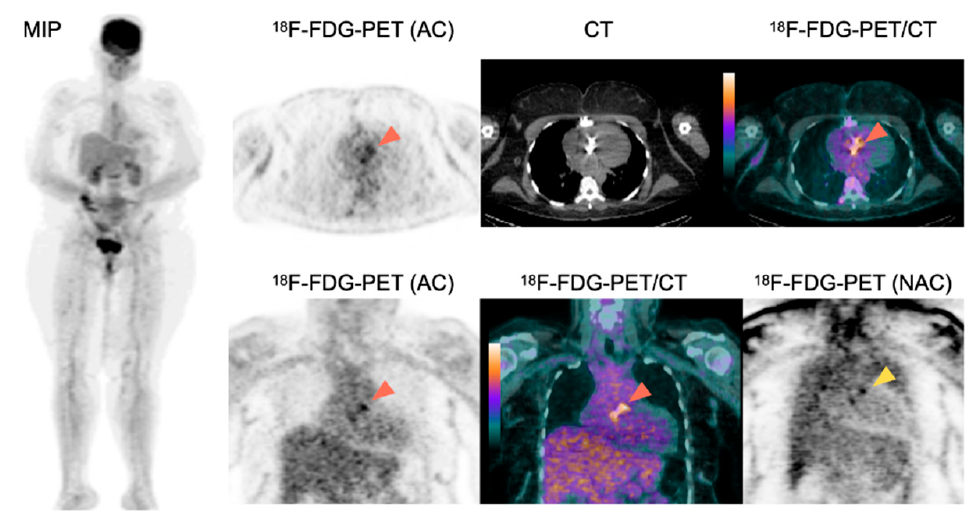
Figure 1. Role of 18 F-FDG-PET/CT for the diagnosis of PVE. A 63-year-old female patient with history of aortic valve replacement presented with a fever of unknown origin. Two blood cultures taken 12 h apart were positive for Staphy- lococcus aureus . 18 F-FDG-PET/CT showed an intense 18 F-FDG uptake around the aortic prosthetic valve on AC images (orange arrowheads), persisting on NAC images (yellow arrowhead) suggestive of PVE. The presence of two major criteria for IE classified the pa- tient as having definite IE based on the modified Duke-Li criteria. 18 F-FDG-PET showed no sign of septic emboli. Consequently, the patient underwent a prosthetic valve replacement surgery and a prolonged antibiotherapy. Conversely, the homogeneous perivalvular 18 F-FDG signal, which is only present on AC images but not on NAC images, is less suggestive of PVE [24]. In case of a suspicion of CIED or LVAD infection, focal/linear 18 F-FDG uptake around the material on AC acquisitions, particularly when facing a lead/the pump, and which persists on NAC images, is suggestive of IE [24] (Figure 2). In case of a suspicion of VGI infection, high 18 F-FDG uptake, especially when developing on an underlying vascular abnormality (aneurysm, calcification) is suggestive of infectious graft [24,78]. The use of quantitative and semiquantitative methods based on SUV have been proposed [46,63,72,128–130], but are currently not routinely used.